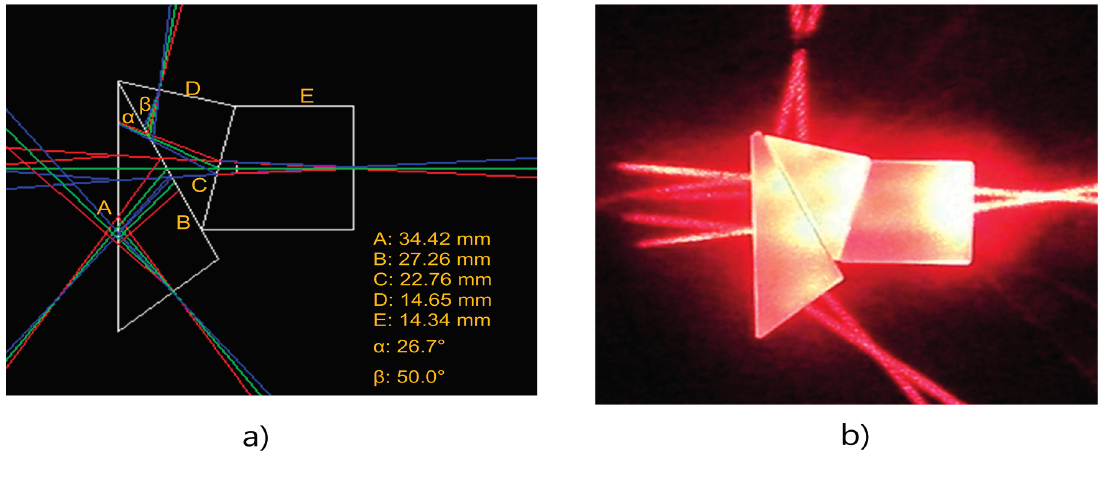
Figure 3. ( a ) Dimensions of the three-waveband beam splitter prisms determined by the simulation software; ( b ) Photo of the prism assembly manufactured with BK7 optical glass. Two-line laser were used to confirm the back focal lengths of the beam splitter